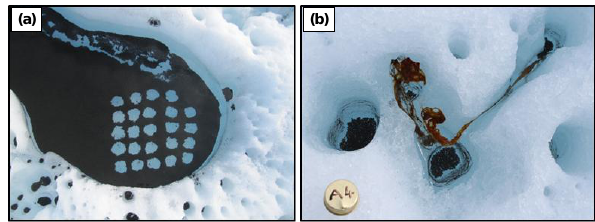
Figure 5. (a) Sample collection for the cryoconite water plus sed- iment incubation (13 July) left 24 round spaces, each about the di- ameter of the BOD bottle ( ∼ 65mm). (b) Orange-green material sampled for the 4th and 9th July incubations. The lid diameter is